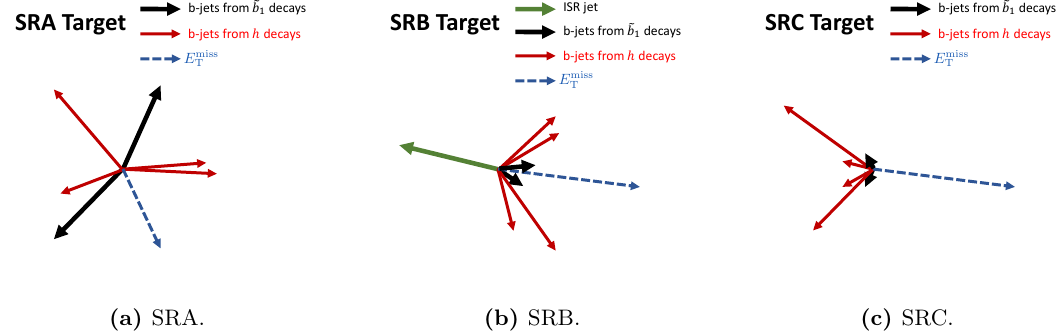
Figure 2. The di(cid:11)erent event kinematics, in the transverse plane, targeted by the three SRs: (a) kinematics in the bulk region, with high- p T b -jets arising from the bottom-squark decay; (b) kinematics in the compressed region of the (cid:1) m (~ (cid:31) 0 the bottom squark; (c) kinematics in the compressed region of the m (~ (cid:31) 0 also contains soft b -jets from the bottom